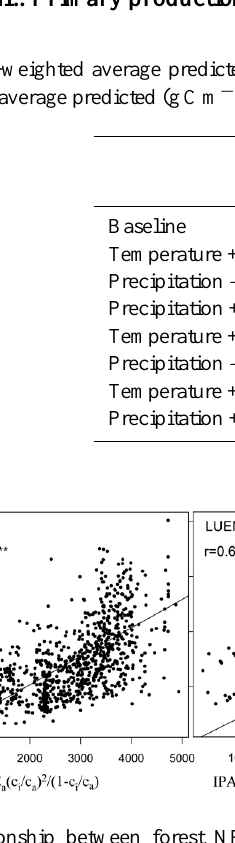
Fig. 2. Relationship between forest NPP and predictors in the Level 1 WUE and LUE